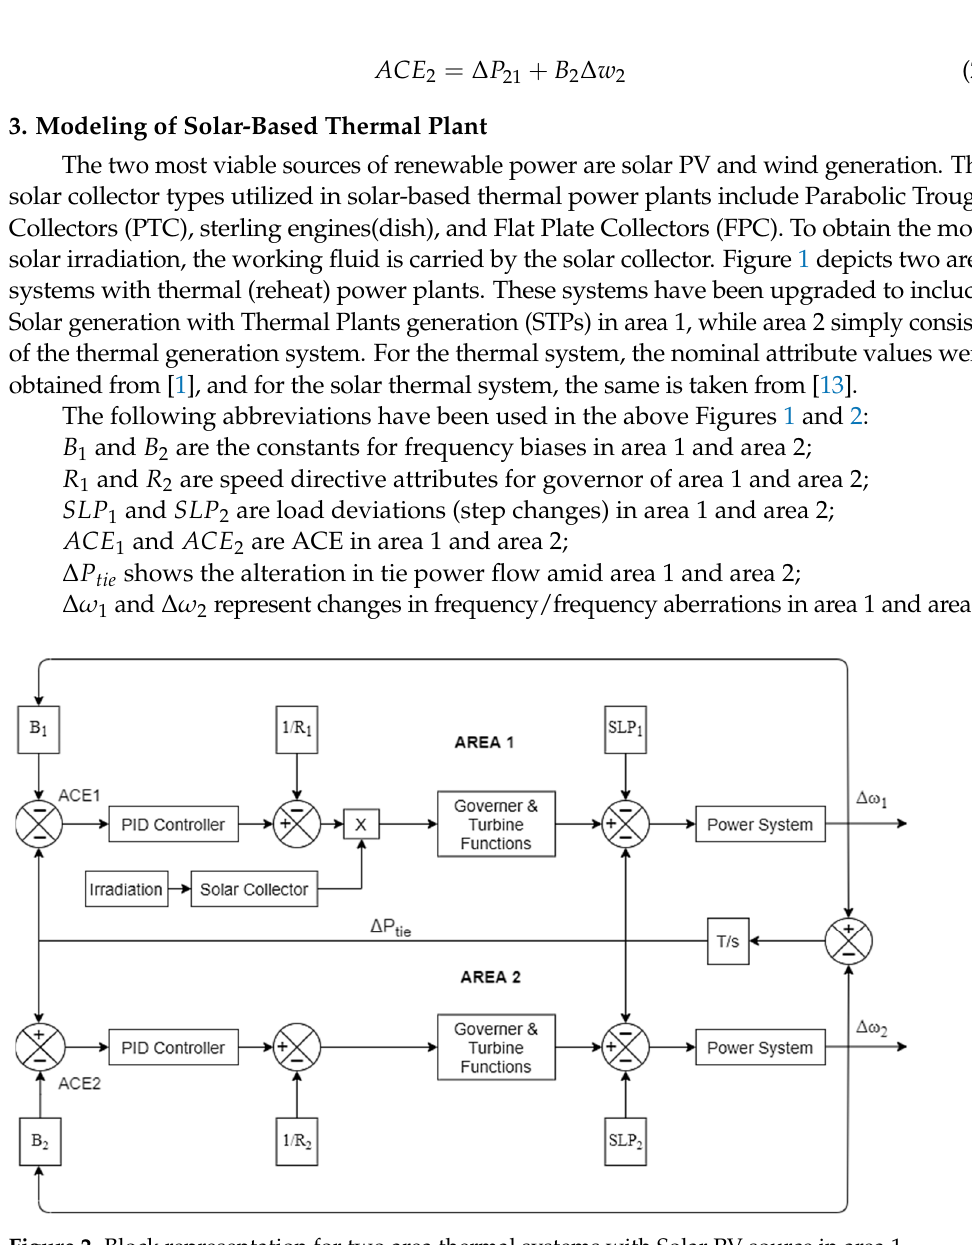
Figure 2. Block representation for two area thermal systems with Solar PV source in area 1. In Figure 3, arrow T i indicates the direction of fluid flow. A fluid of temperature T o